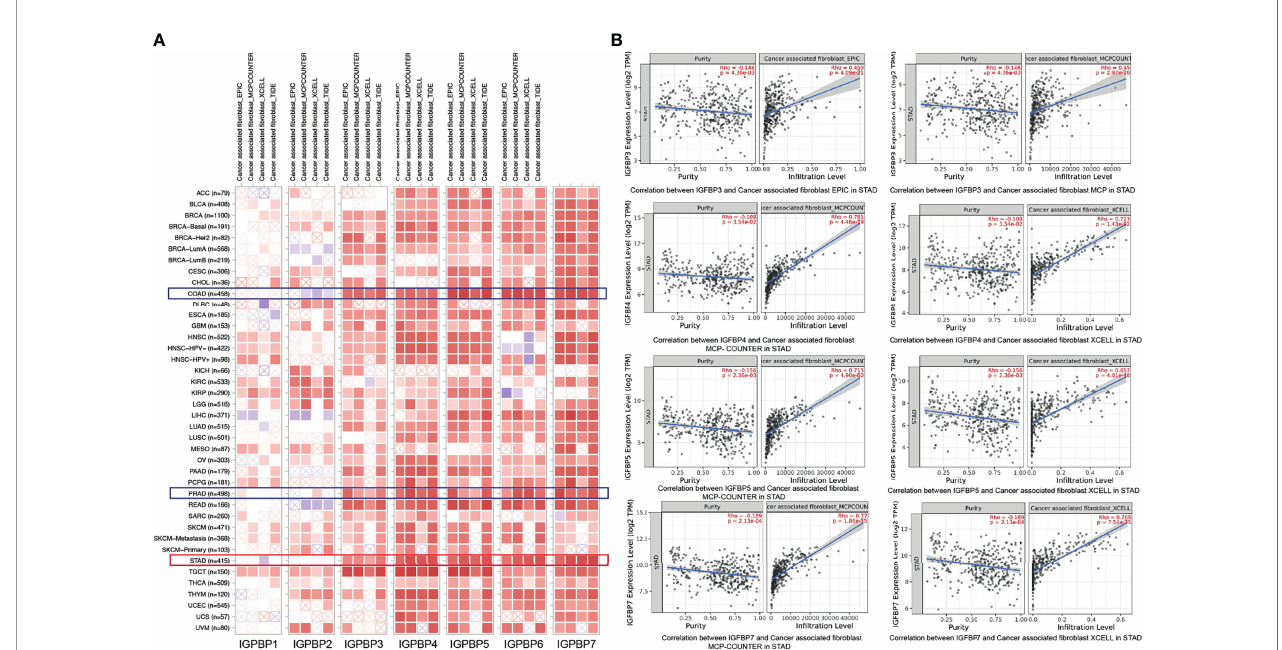
FIGURE 7 | Correlations between differentially expressed IGFBPs and immune cell in fi ltration (TIMER). (A) Correlations between abundance of immune cells and expression of IGFBP1 – 7 in 40 different cancer types. (B) Examples of IGFBP3/4/5/7-related tumor immune cell in fi ltration in STAD